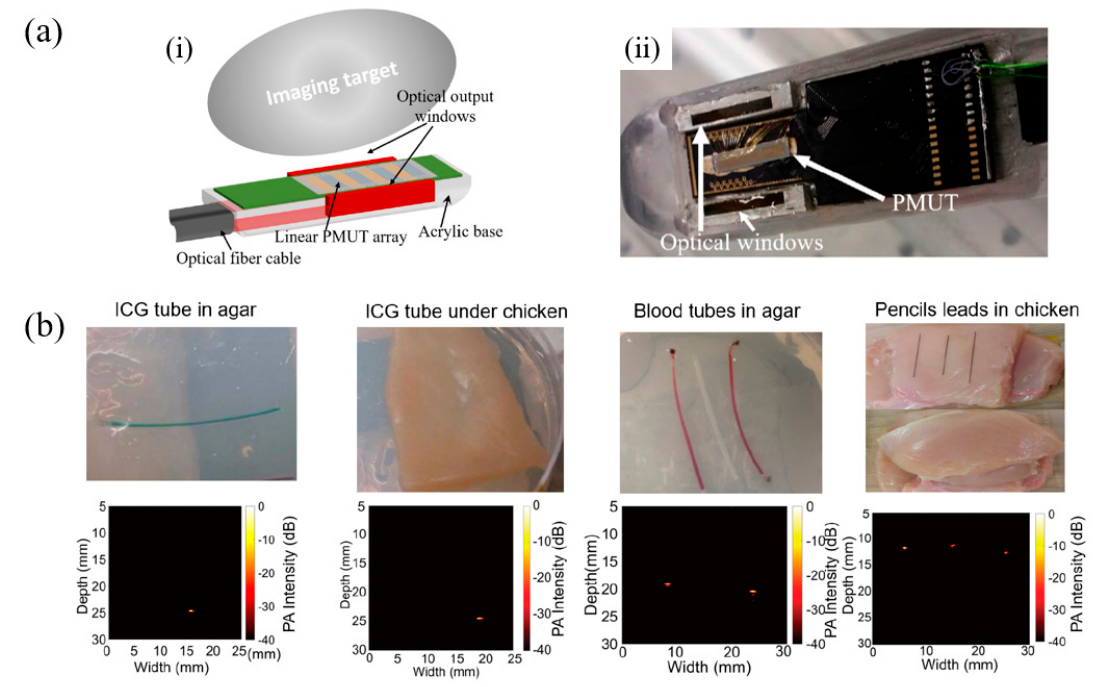
Figure 21. ( a ) Schematic representation (a-i) and photograph (a-ii) of the pMUT-based PAI probe. ( b ) Photographs (top) and corresponding B-mode photoacoustic images (bottom) of targets with different imaging conditions (Reproduced with permission from IEEE [142]).